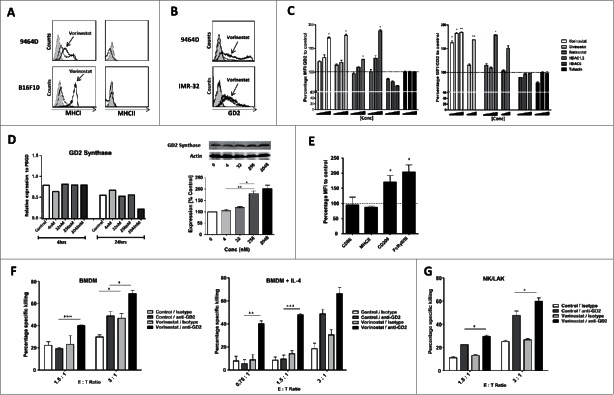
HDACi increase GD2 expression by NBL cells resulting in increased anti-GD2 mAb-mediated killing. (A) Expression of MHCI and MHCII by 9464D and B16F10 cells following incubation with 256 nM Vorinostat or control for 18 h. Gray shading = isotype control, Thin line = control treated, Thick line = Vorinostat treated. Representative data from three independent experiments are shown. (B) Expression of GD2 by 9464D and IMR-32 cells after incubation with 2.5 μM and 256 nM Vorinostat, respectively, for 18 h. Gray shading = isotype control, Thick line = specific staining. Representative data from three independent experiments are shown. (C) Expression of GD2 relative to control by 9464D and IMR-32 cells after incubation with the indicated HDACi for 18 h. Mean Fluorescence Intensity (MFI) of GD2 is depicted. Pooled data from three independent experiments are depicted (*p < 0.05, **p < 0.01). (D) 9464D cells were exposed to indicated concentrations of Vorinostat for 24 h after which cells were lysed and analyzed by qPCR (left) and Western Blot (right) for expression of GD2 Synthase (*p < 0.05, **p < 0.01). Representative data from two independent experiments are depicted. (E) Day 6 BMDM were treated with 20 ng/mL IL-4 for 24 h and analyzed for the expression of CD86, MHCII, CD206 and FcRγ2/3. Pooled data from two independent experiments are depicted (*p < 0.05). (F,G) Treatment of 9464D cells with Vorinostat increases anti-GD2 mAb mediated killing. 9464D cells were incubated for 18 h with 256 nM Vorinostat or control and then co-cultured with indicated effector cells in the presence of isotype control Ab or anti-GD2 mAb (*p < 0.05, **p < 0.01, ***p < 0.001). Representative data from 2–3 independent experiments for each immune effector cell type are shown.